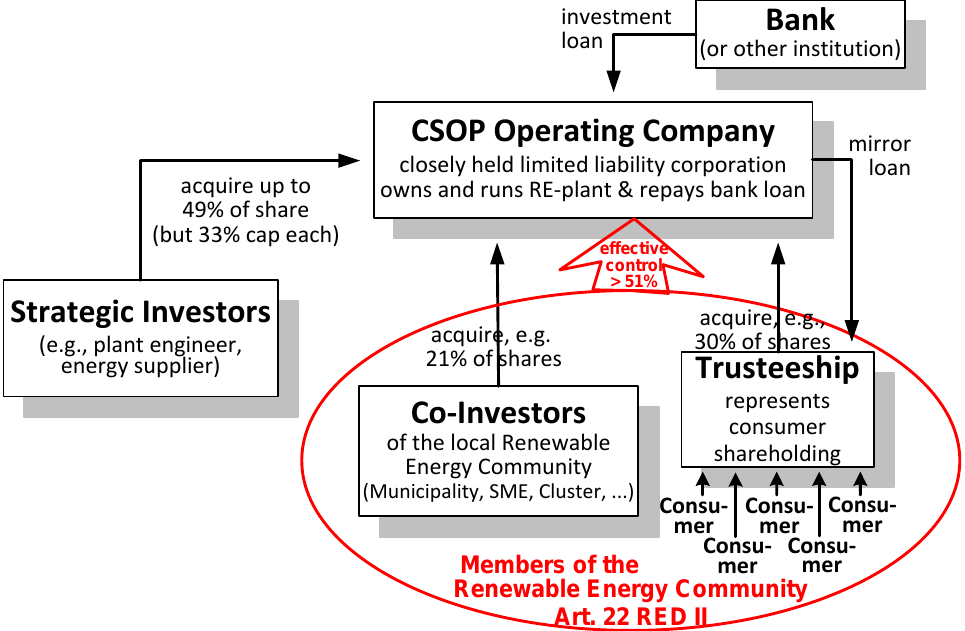
Figure 3. Key elements of the RE-CSOP financing structure in the base model for a REC. Source: Own elaboration.